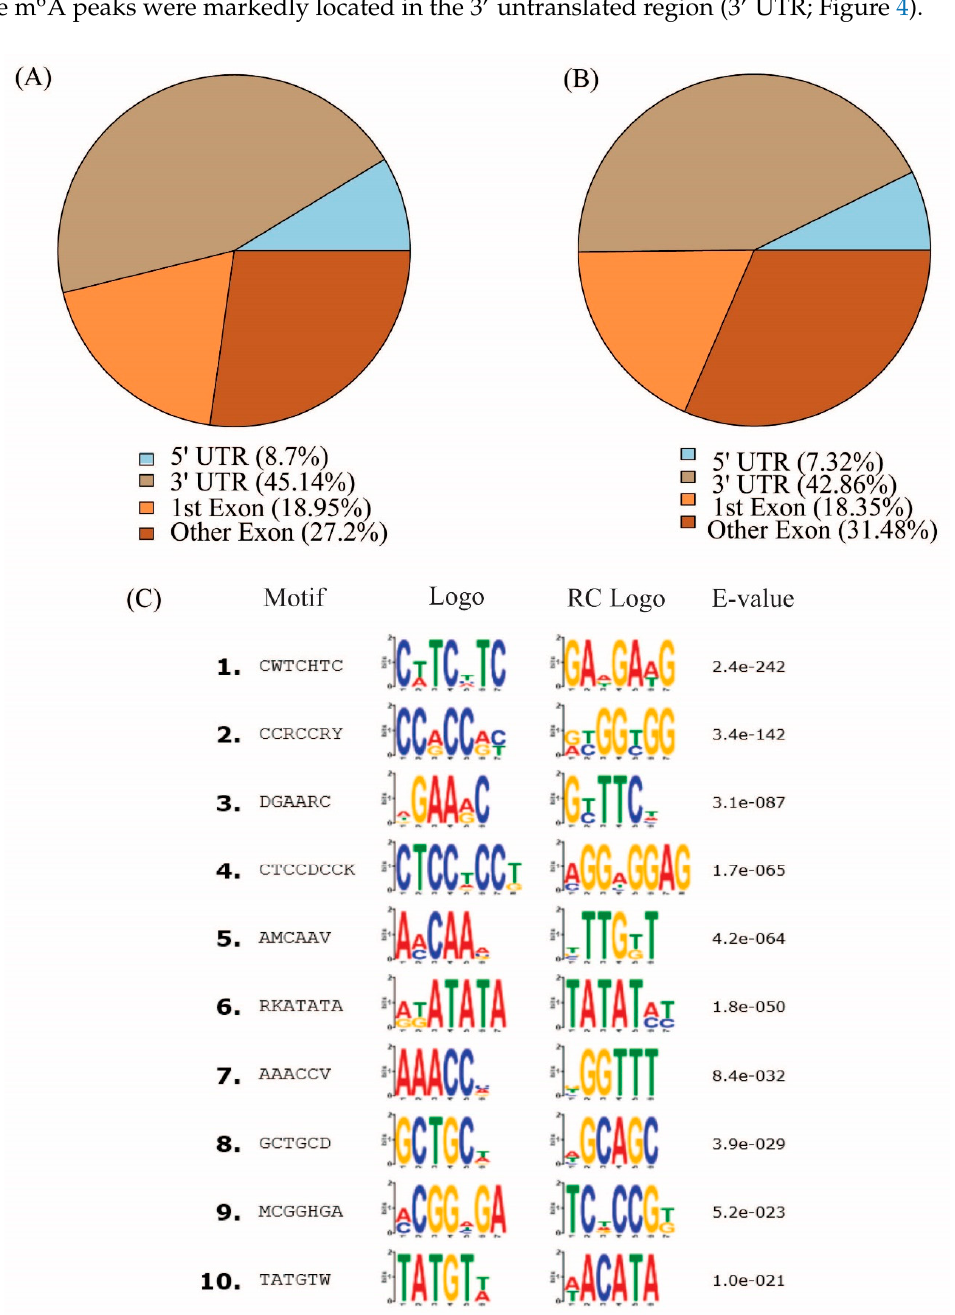
Figure 4. Distribution of m 6 A peaks within transcripts divided into 5 ′ UTR, 1st exon, 3 ′ UTR, and other exons. ( A ) CK group; ( B ) T43 group; ( C ) the consensus motifs enriched with m 6 A peaks in the CK group.